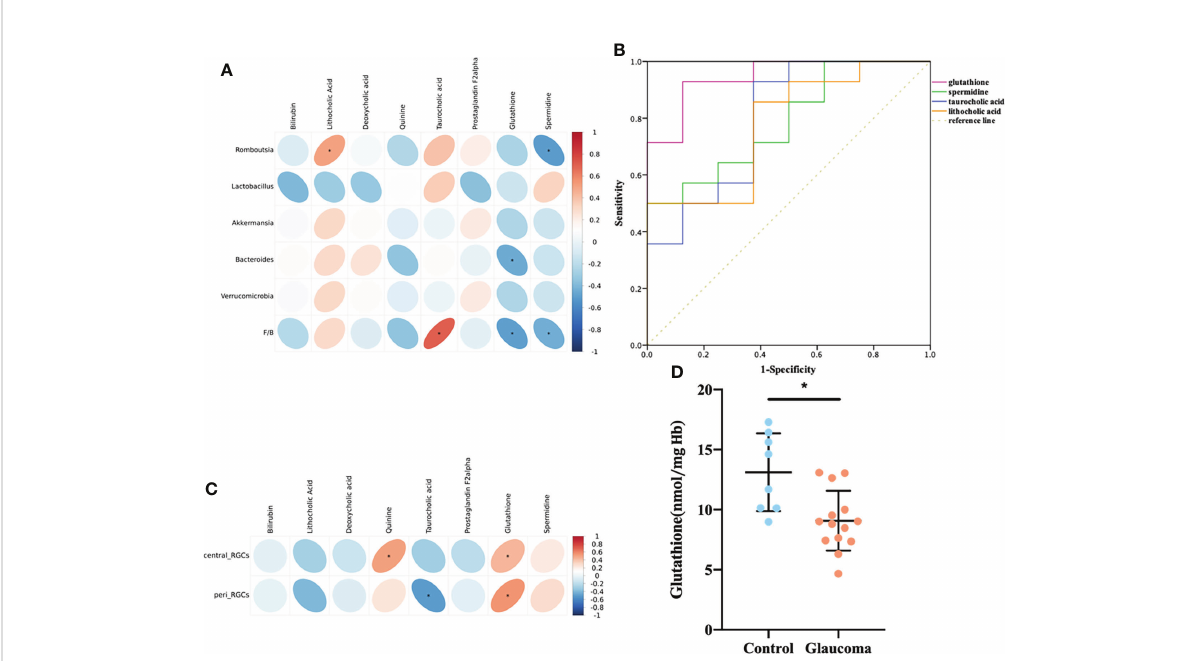
FIGURE 5 Relationship among the metabolites enriched in the bile secretion pathway, differentially expressed cecal microbiota and RGCs. (A) Correlation between differential bacteria and metabolites involved in the bile secretion pathway. (B) Receiver-operating characteristic (ROC) curve analysis of metabolites. The area under the curve (AUC) values close to 1 indicates that a high TPR is achieved with low FPR. (C) Correlation between differential metabolites involved in the bile secretion pathway and central/peripheral RGCs. (A, C) Correlation coef fi cient is on the right side, and red indicates positive correlation and blue indicates negative correlation. (D) Comparison of the glutathione in blood between glaucoma and control groups. *P<0.05. RGC, retinal ganglion cell; TPR, true positive rate; FPR, false positive